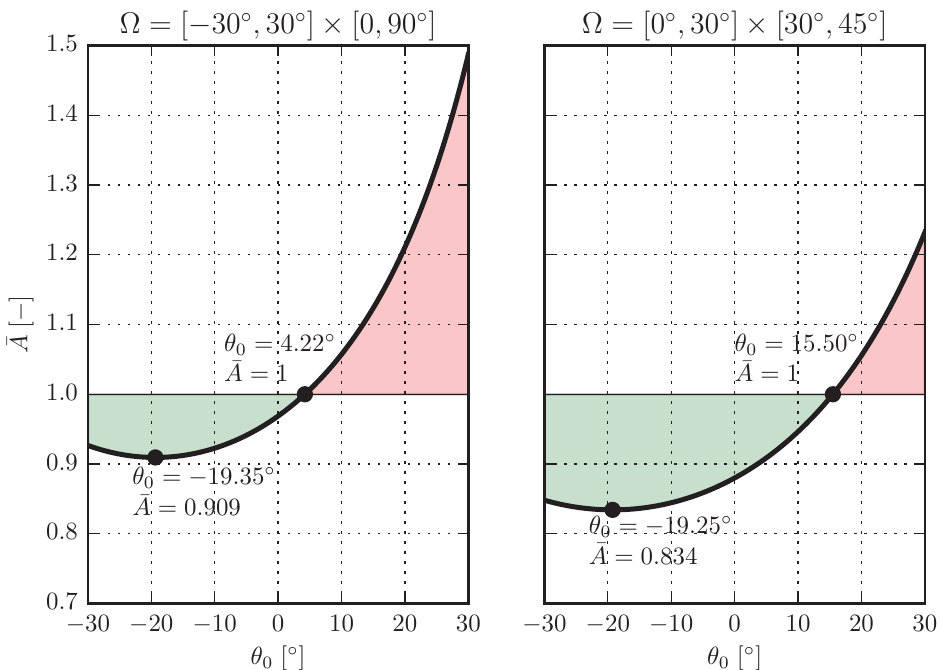
Figure 3: Integral